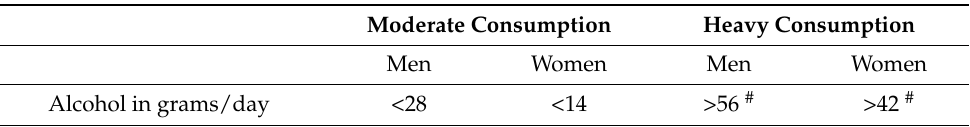
Table 1. Classification of alcohol consumption according to National Institute on Alcohol Abuse and Alcoholism